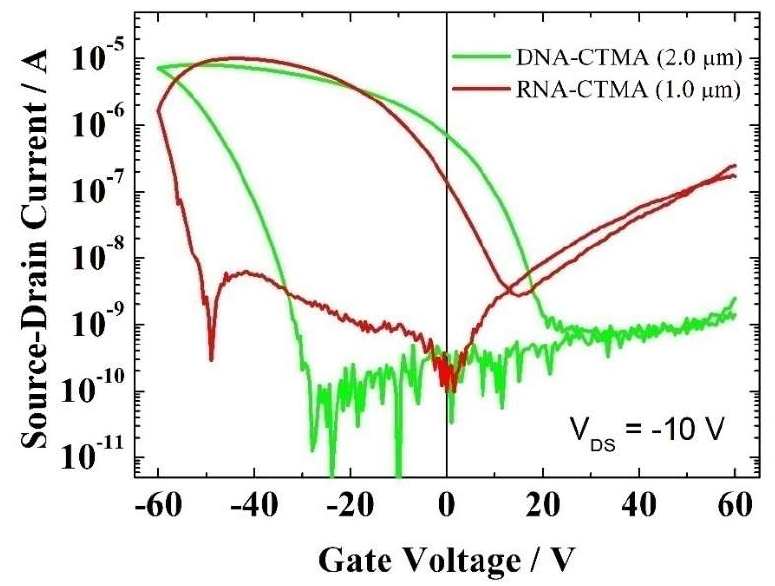
Figure 6. Transfer characteristics of BiOTFTs with DNA and RNA complex as the gate dielectric.